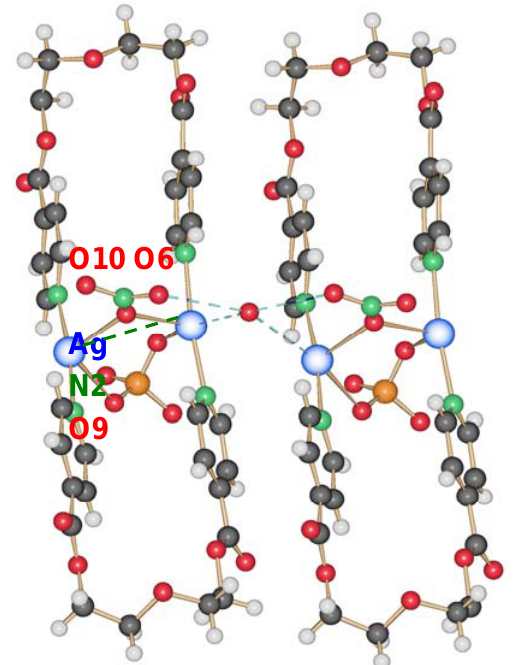
Figure 12. Interaction between two rings of compound 13 ; light blue dotted lines indicate H-bonding and weak coordination to silver ions of O10; the green dotted line indicates Ag– 